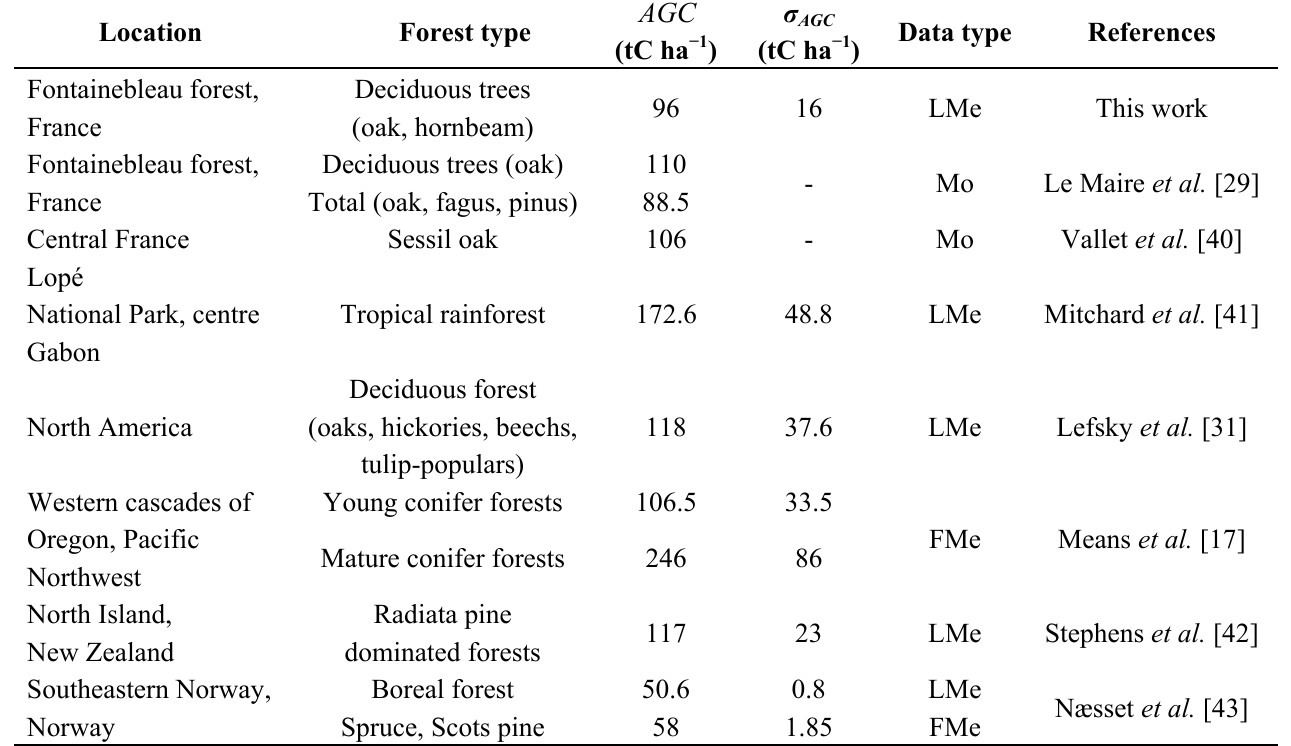
Table 5. AGC synthesis from different references a